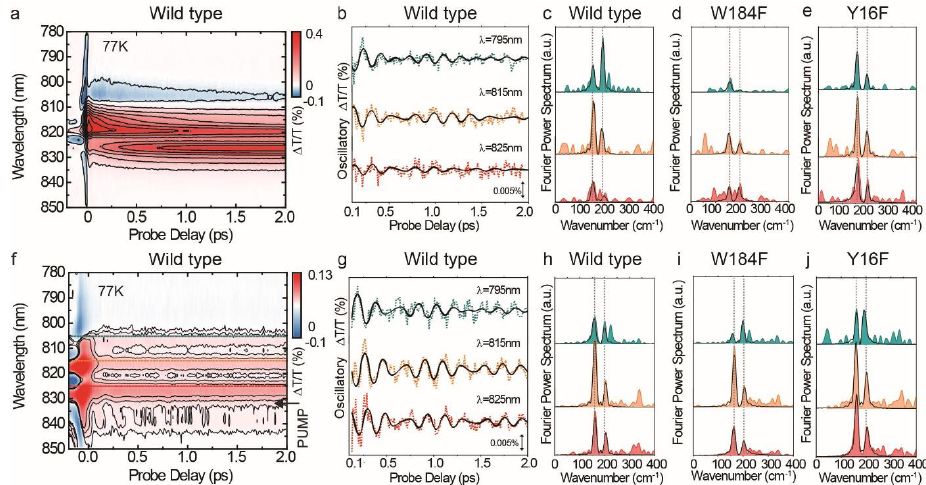
Fig. 2. Pump-probe map at 77K for the wild type FMO complex measured upon (a) broadband pump excitation and (f) selective red-edge excitation. (b) Selected residual oscillations obtained after removing a two-exponential decay component from the pump-probe data in (a). (c) Corresponding Fourier spectra obtained from (b) for the wild type and for W184F (d) and Y16F (e) obtained at the same probe wavelength. (g) Selected residual oscillations obtained after removing a two-exponential decay component from the pump-probe data in (f). (h) Corresponding Fourier spectra obtained from (g) for the wild type and for W184F (i) and Y16F (j) obtained at the same probe